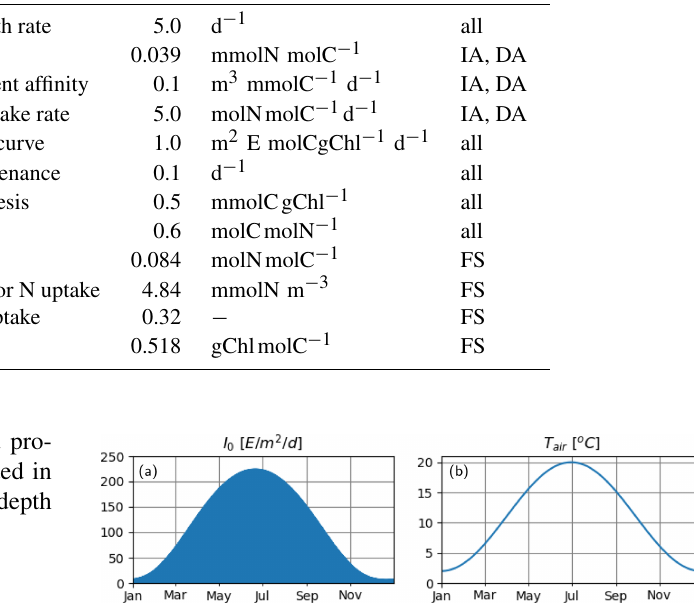
Table 3. Descriptions, values and units of model parameters regarding phytoplankton growth. Prescribed values for Q , K N , f V , and ˆ θ are based on the biomass-weighted averages estimated by the IA variant. All other parameter values are taken from within the published range (Pahlow et al., 2013; Smith et al., 2016), without particular reference to species. Term/symbol Definition Value Unit Used by − 1 all ˆ µ 0 Potential maximum growth rate 5.0 d Q 0 Subsistence quota